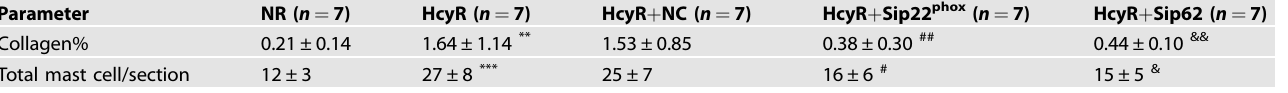
Values are means± SD; n = no. of rats/group. Collagen% is the ratio of collagen to luminal area. ** p <0.01, *** p <0.001 vs. NR; # p < 0.05, ## p < 0.01 vs. HcyR + NC; & p < 0.05, && p <0.01 vs. HcyR + NC. NR normal rat, HcyR homocysteinemic rat, HcyR + NC homocysteinemic rat treated with non-targeting control siRNA, HcyR + Sip22phox homocysteinemic rat treated with p22phox siRNA, HcyR + Sip62 homocysteinemic rat treated with p62